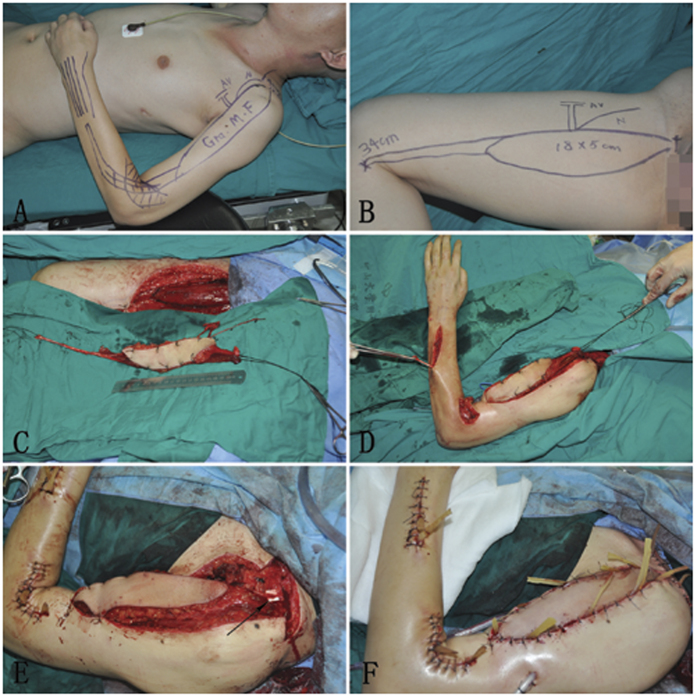
(A) Surgical design of the recipient site before operation; (B) Surgical design of the donor site before operation; (C) Showed the gracilis was dissected from the thigh; (D) The gracilis was placed subcutaneously in the anterio-medialis aspect of the arm; (E) The nerve of the gracilis was anastomosised to the accessory nerve (arrow); (F) Rubber sheets and tube were used for drainage after surgery.